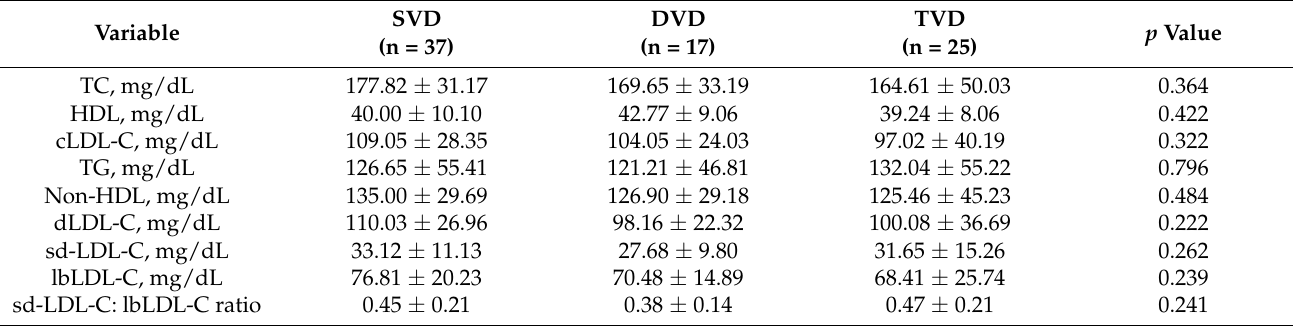
Table 5. Lipid profile according to angiographic findings